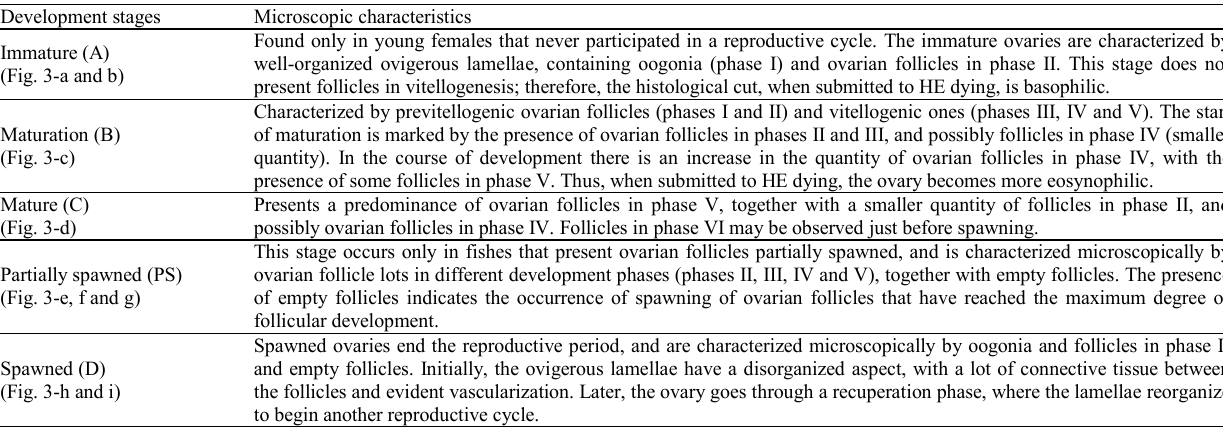
Table 2. Microscopic description of the main characteristics that determine the ovarian development stages of Etropus crossotus , obtained in the shallow infralittoral areas of the Paranaguá Estuarine